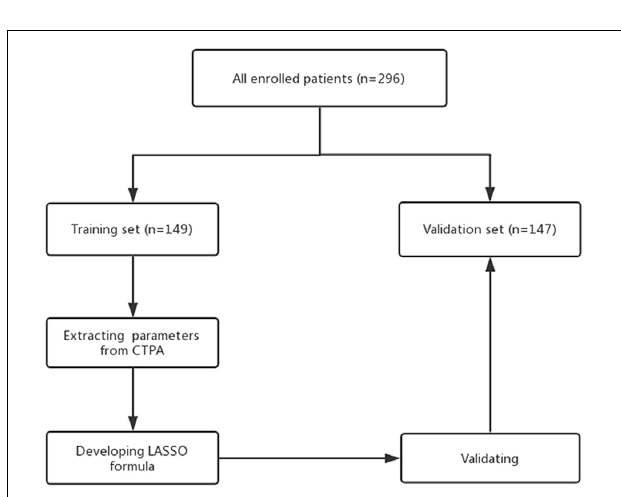
FIGURE 2 | Flow chart of the validation process.